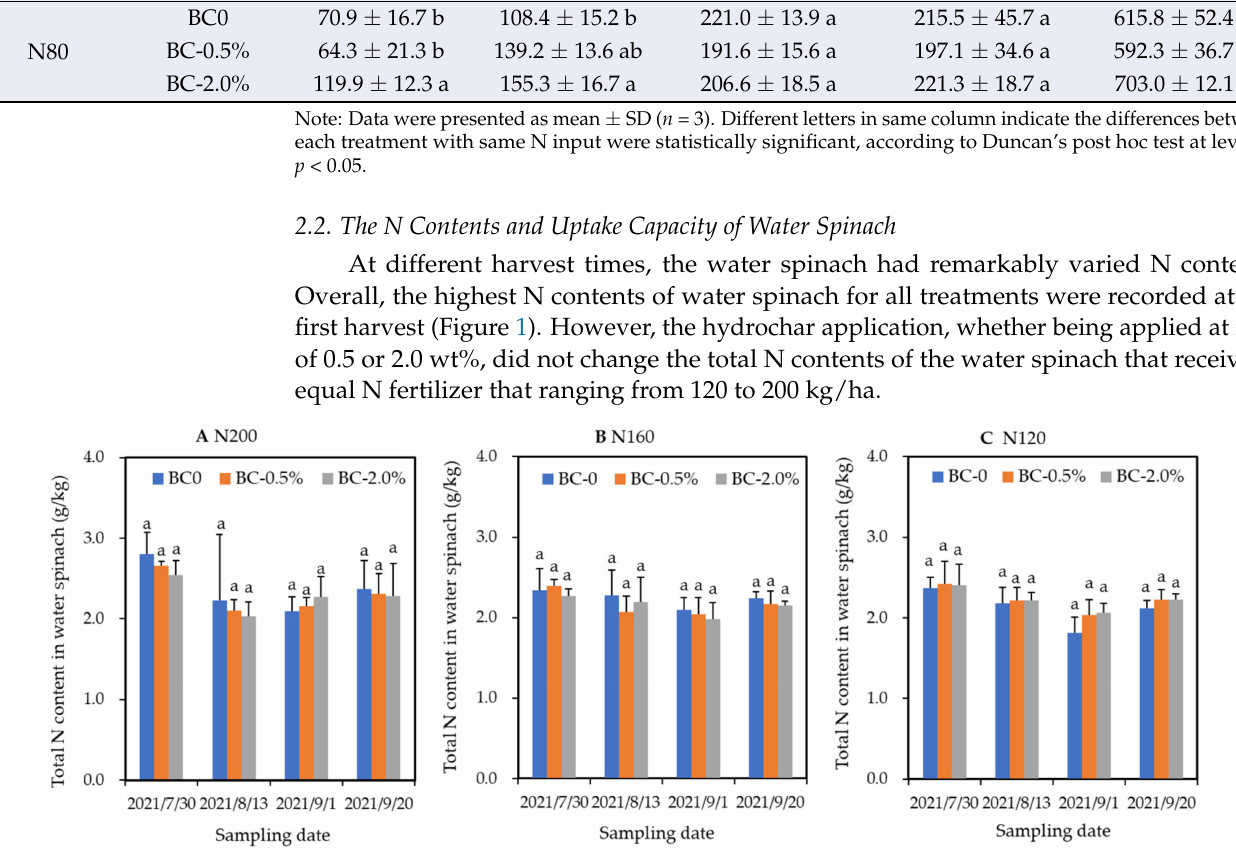
Figure 1. Responses of N contents of water spinach to hydrochar amendments under three N-inputs, i.e., 200 kg/ha ( A ), 160 kg/ha ( B ). and 120 kg/ha ( C ). Error bars represent the SD of the mean of three replicates. Identical letters above each column in the chart indicate the differences between each treatment with same N input were not statistically significant, according to Duncan’s post hoc test at level of p <